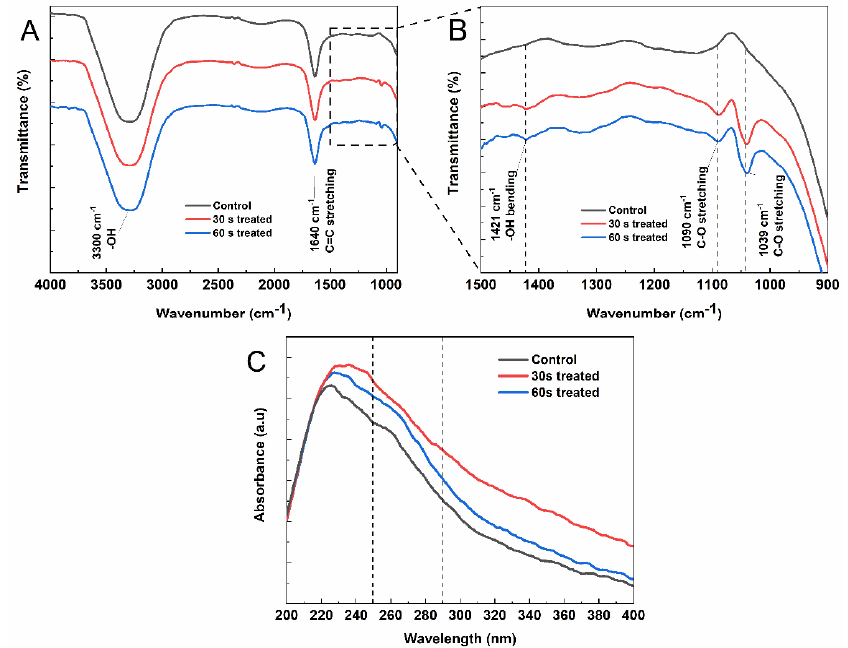
Figure 3. Fourier transform infrared spectra and UV-Vis analysis of extracts of nonthermal gas plasma-treated mushroom-derived extracts. Fourier transform infrared spectra of F. velutipes extract ( A ) 900–4000 cm −1 and ( B ) 900–1500 cm −1 . Black line, control (0 s not exposed to plasma); red line, exposed to plasma for 30 s; blue line, exposed to plasma for 60 s; ( C ) UV-Vis absorption spectra of F. velutipes extracts. Black line, control (0 s not exposed to plasma); red line, exposed to plasma for 30 s; and blue line, exposed to plasma for 60 s.